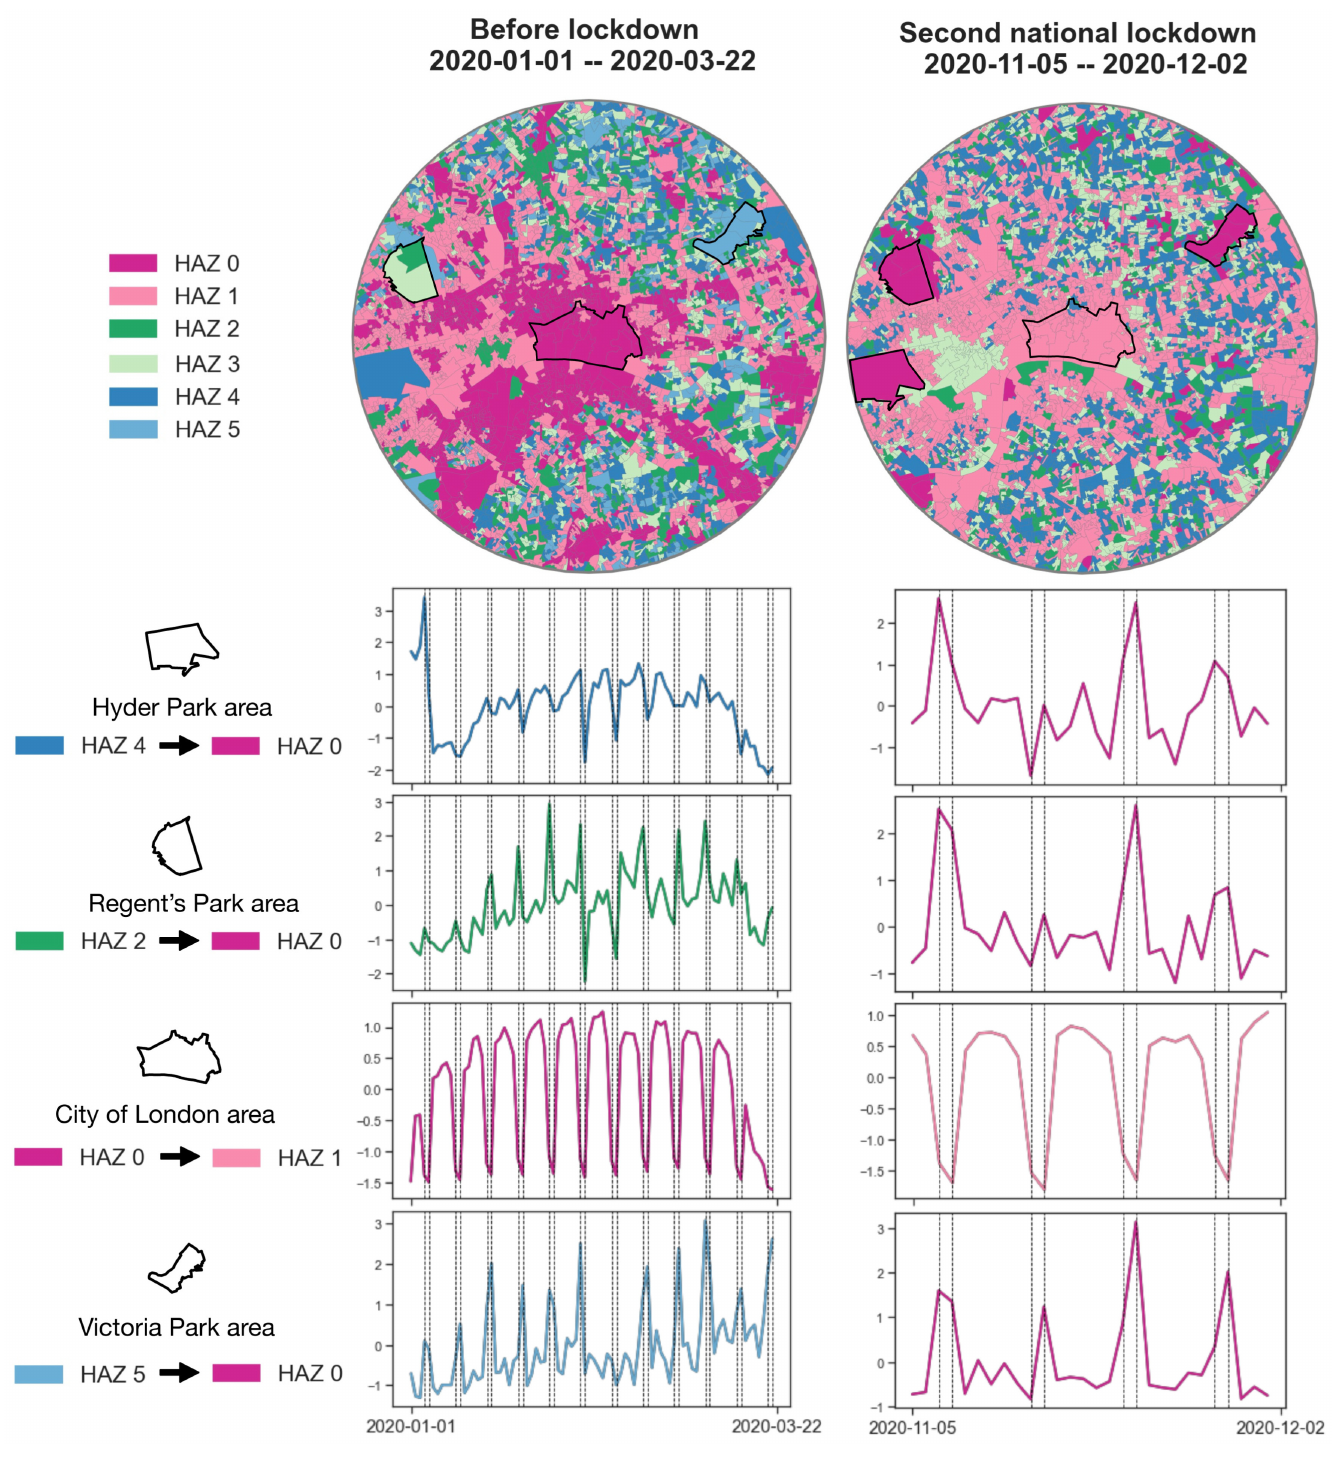
Fig 9. The HAZs within the urban centre’s buffer area (6 km) in the before lockdown phase and the second national lockdown phase. Geographical boundary data source: Office for National Statistics licensed under the Open Government Licence v.3.0. Contains OS data © Crown copyright and database right 2022. Contains National Statistics data © Crown copyright and database right